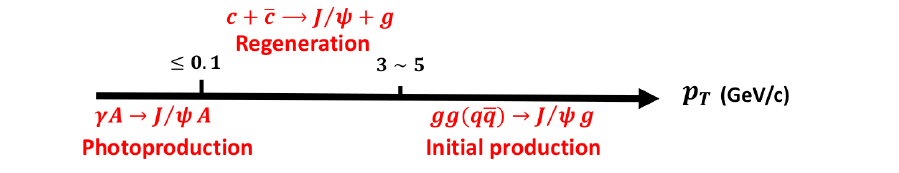
Figure 1. Schematic figure for charmonium initial production, regeneration, coherent photoproduction dominated in di ff erent transverse momentum p T . The figure is cited from